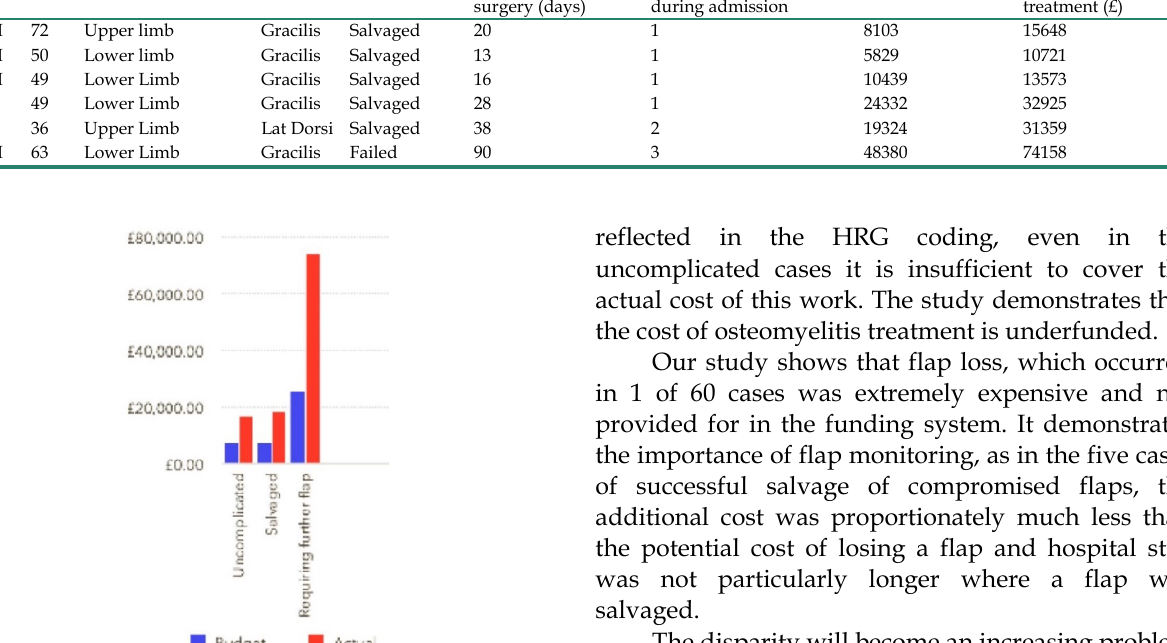
Table 1 . summarising 6 patients who required urgent re-operation Sex Age Site of osteomyelitis Flap